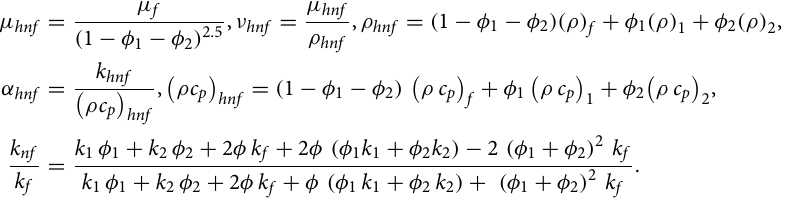
Theoretic model for hybrid nanofluid is 14 :